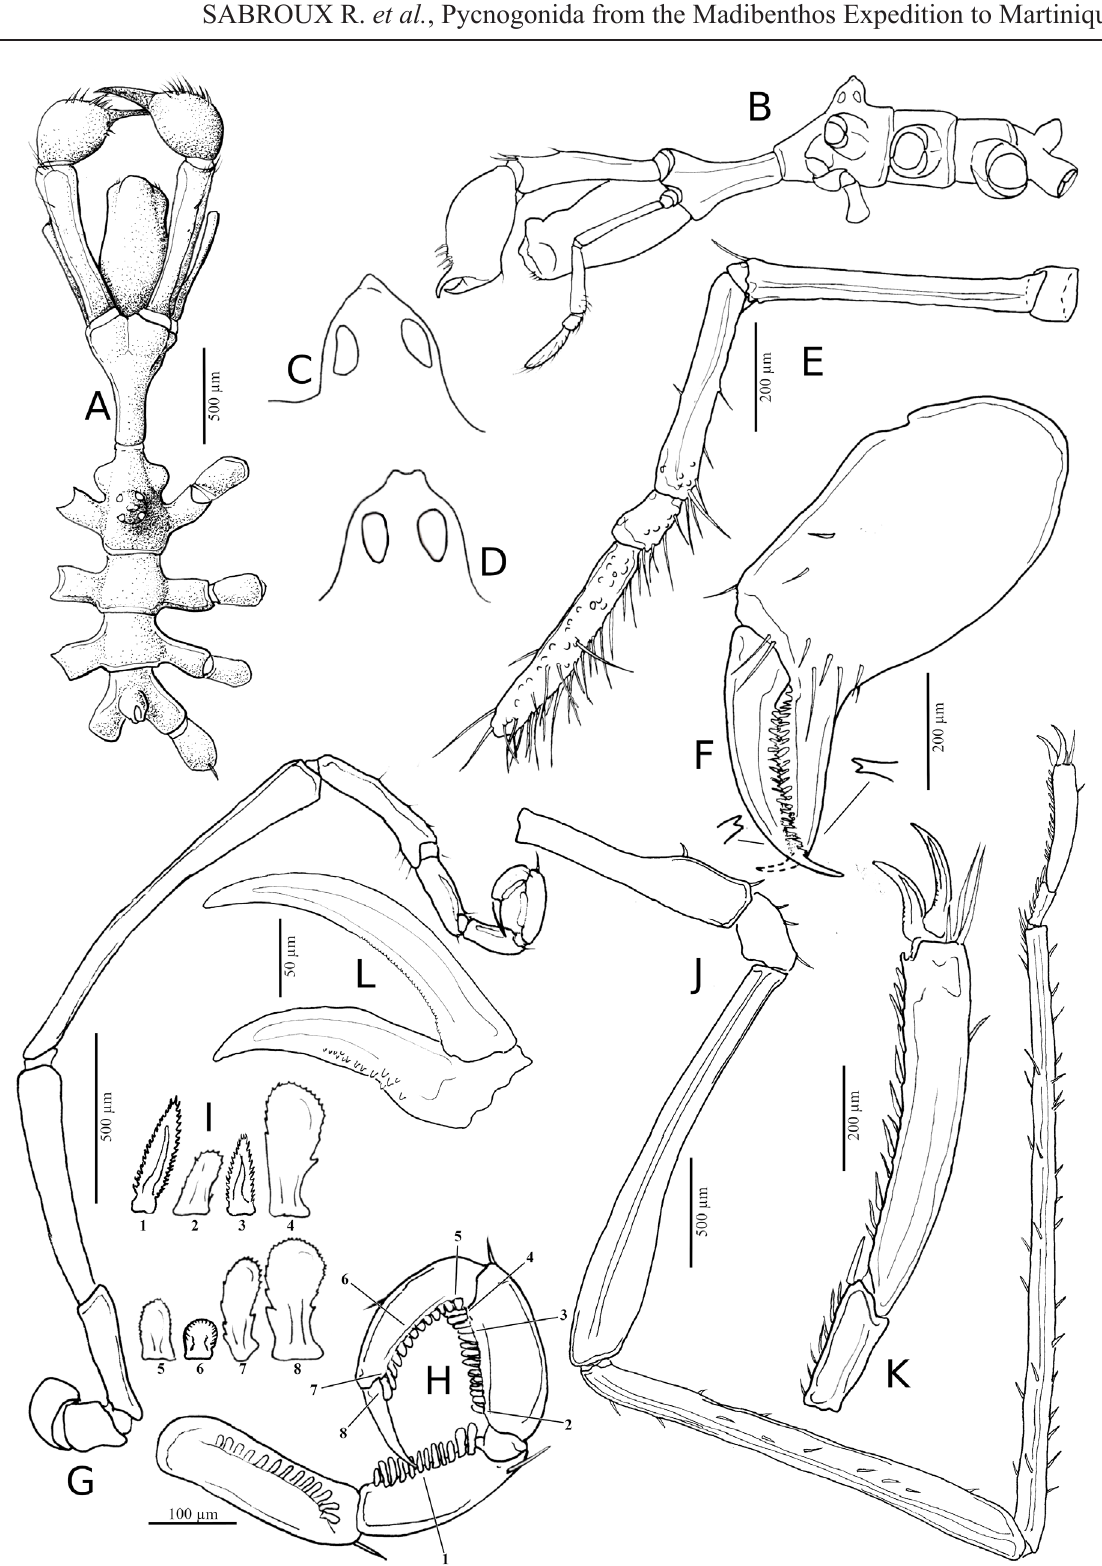
Fig. 12. Nymphon ludovici sp. nov., holotype, ♂, MNHN-IU-2016-835. A . Body, dorsal view. B . Body, lateral view (same scale as A). C . Ocular tubercle, lateral view. D . Ocular tubercle, frontal view. E . Palp. F . Chelifore, with close-up of two bifid teeth. G . Oviger. H . Strigilis. I . Pointed teeth of strigilis. J . Fourth leg. K . Tarsus and propodus of fourth leg. L . Propodal